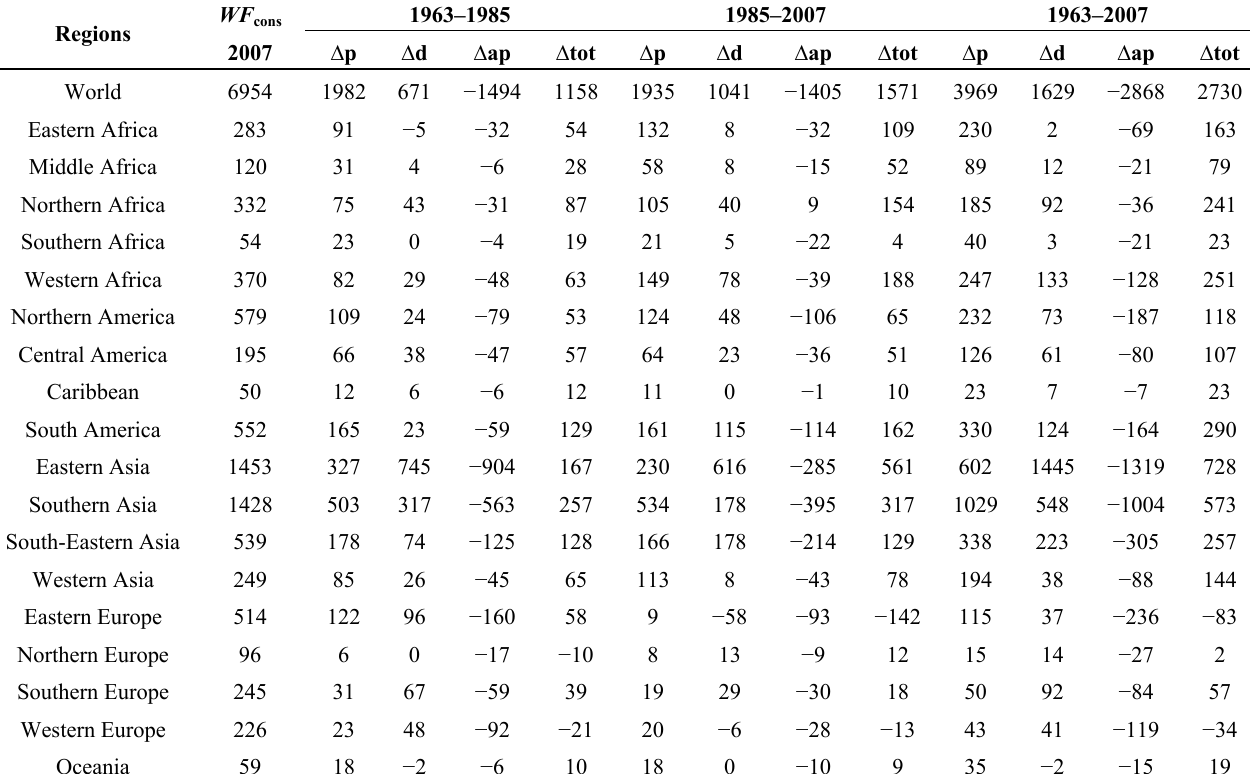
Table 1. Decomposition analysis according to the contributions of diet, agricultural practices and population to changes in WF contributions of changes in diet ( Δ d), agricultural practices ( Δ ap) and population ( Δ p) are presented in the table. Values were derived based on data presented in Figure 2 using the logarithmic mean Divisia index (LMDI) decomposition method; following the WF